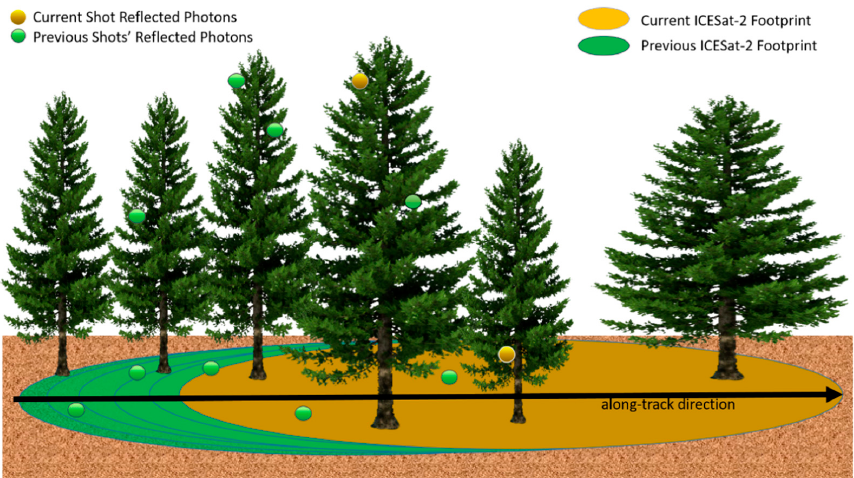
Figure 3. Conceptual illustration depicting photon sampling over vegetation.